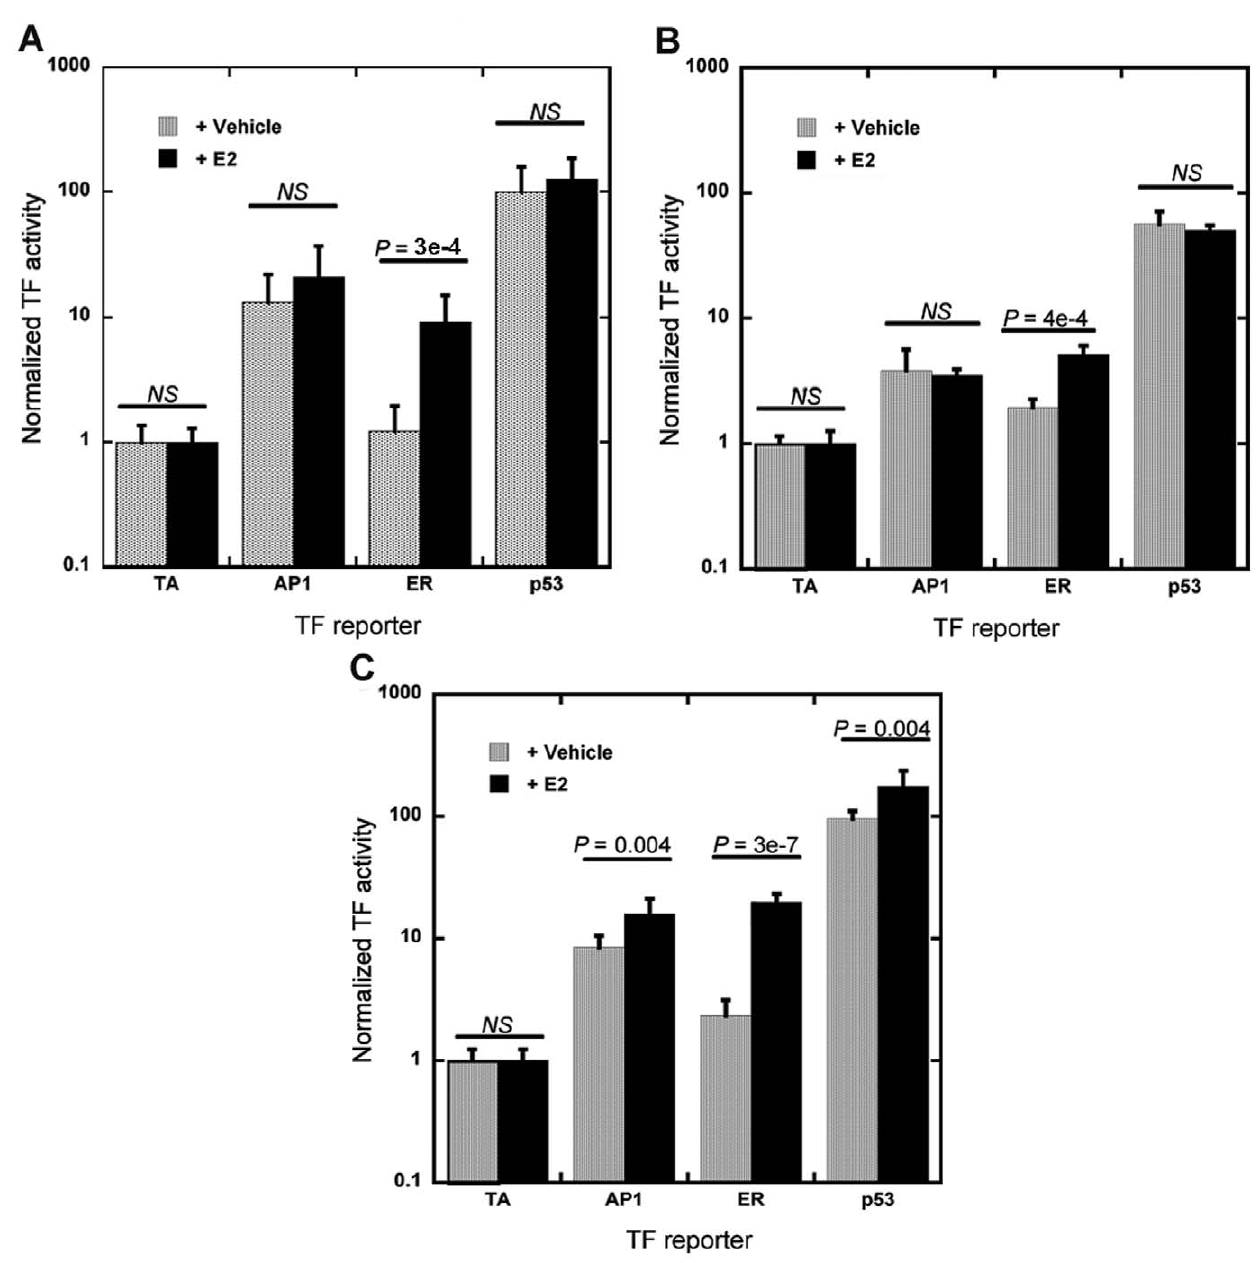
Figure 3. Dual-luciferase constructs to capture changes in TF activity in response to E 2 treatment. (A,B) MCF-7/WS8 cells transfected with pFLuc and pGLuc reporter constructs and seeded within Matrigel were treated with E 2 for 24 h. TF activity was measured by extracting cells from hydrogels and lysing (A) or by bioluminescence imaging (B). (C) MCF-7/WS8 cells were grown on 2D polystyrene, transfected, and treated with E 2 for 24 h. TF activity was measured by lysing cells. Values are means 6 s.d. from at least three independent experiments carried out in triplicate. NS indicates no significant difference with treatment.